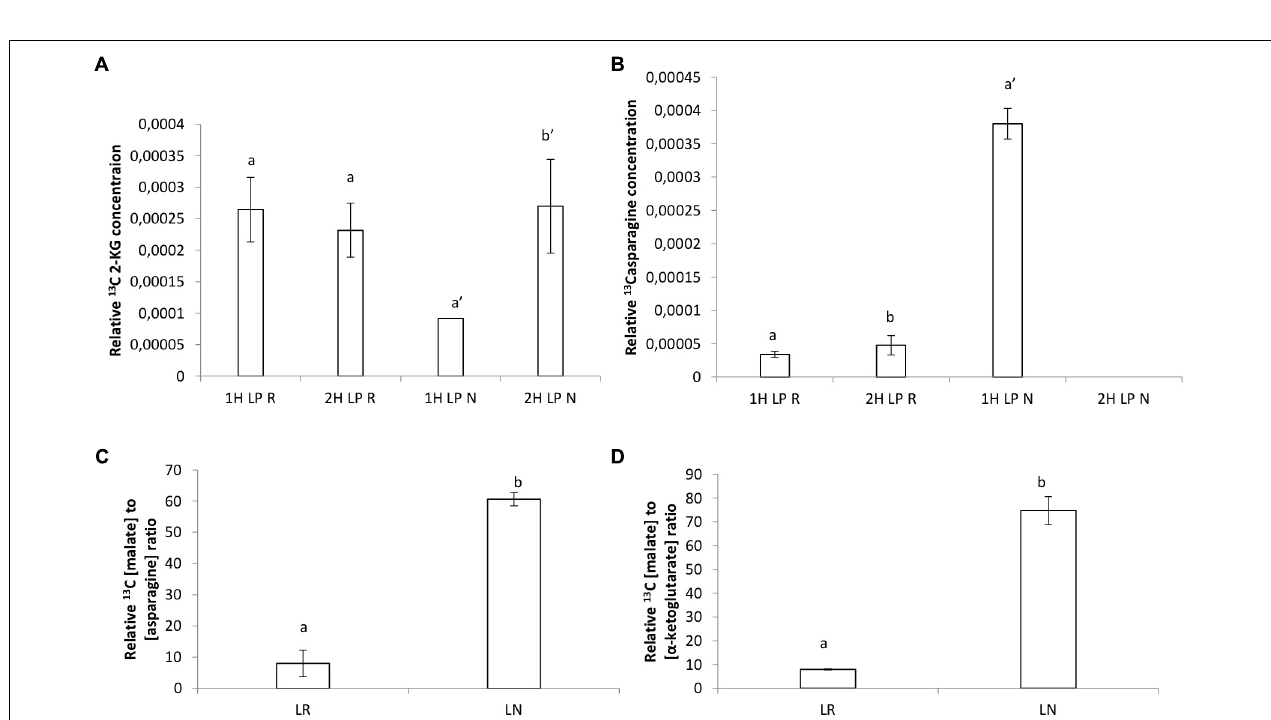
FIGURE 7 | (A) Relative 13 C α -ketoglutarate concentration after 1 h, (B) relative 13 C asparagine concentration after 1 h, (C) relative 13 C malate converted to asparagine concentration, (D) relative 13 C malate converted to α -ketoglutarate concentration (mg.ml − 1 )found by 13 C NMR analysis in roots and nodules of V. divaricata , grown under low phosphate (LP) (5 µ M P)